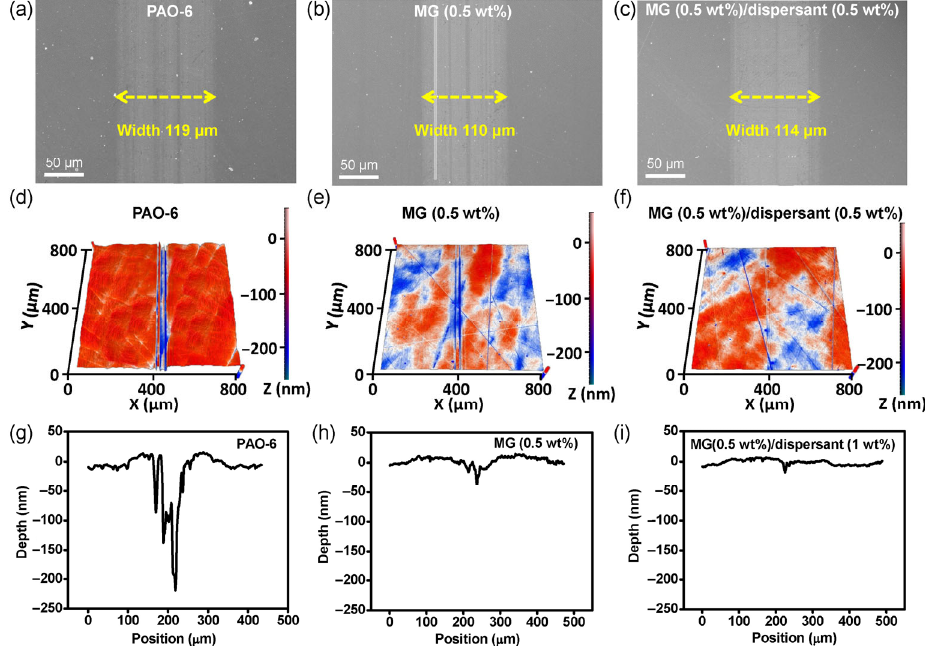
Fig. 4 Scanning electron microscope images, three-dimension surface images and the corresponding surface profiles of wear tracks for (a, d, g) PAO-6, (b, e, h) MG (0.5 wt%), and (c, f, i) MG (0.5 wt%)/dispersant (1 wt%), respectively.